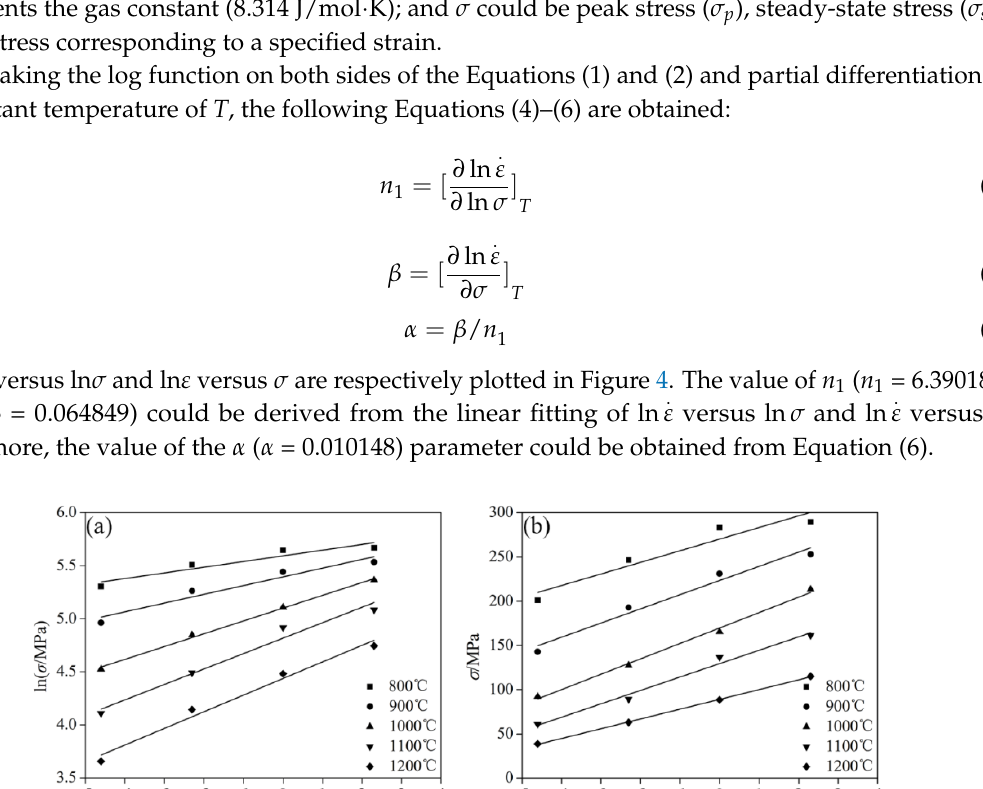
Figure 4. Relationship between peak stress and strain at different temperatures: ( a ) ln ln − , and . ε − σ ( b ) ln − .